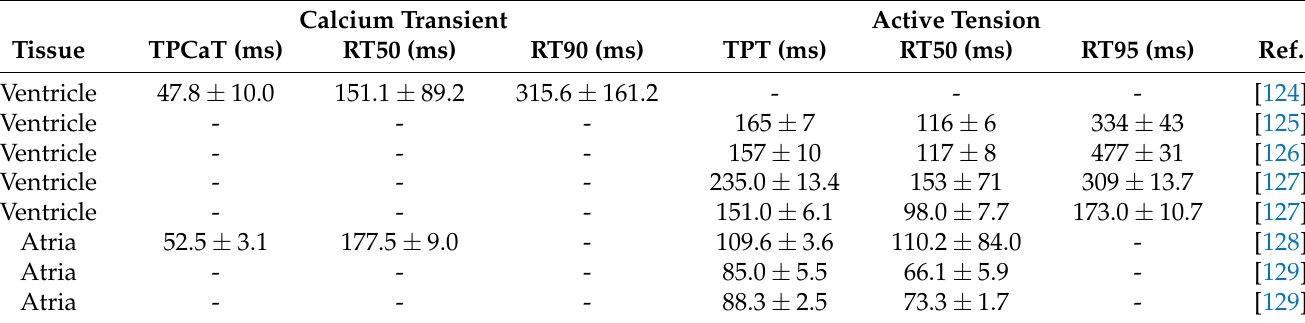
Table 6. Literature values for time to peak of calcium transient (TPCaT) and active tension development (TPT) as well as relaxation time to 50%, 90% and 95% respectively (RT50, RT90, RT95) from human tissue preparations. The list of ventricular values were originally compiled in